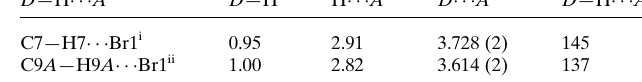
Figure 6 Molecular structure of 2 . Displacement ellipsoids are shown at the 50% probability level. H atoms are presented as small spheres of arbitrary radius. The dashed line indicates the intermolecular non-covalent Se (cid:3)(cid:3)(cid:3) Br interaction.